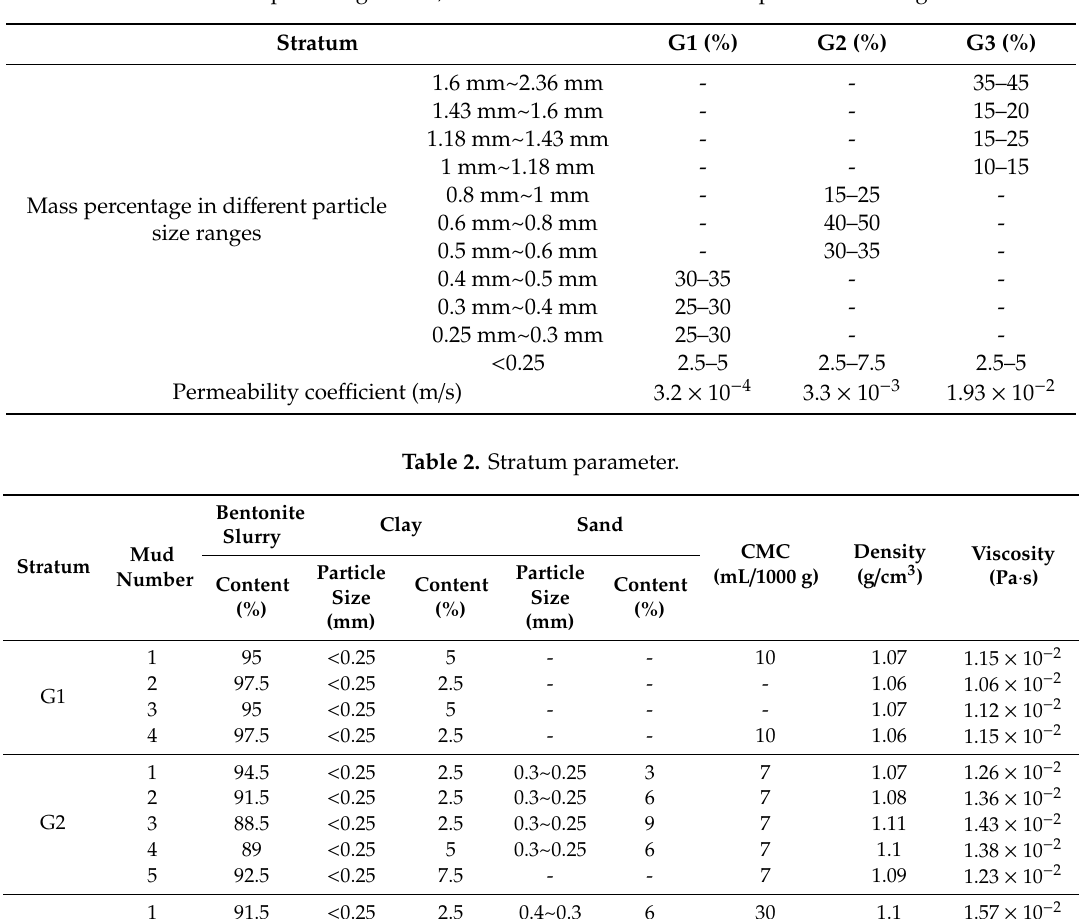
Table 1. Mass percentage of G1, G2 and G3 stratum in di ff erent particle size ranges.